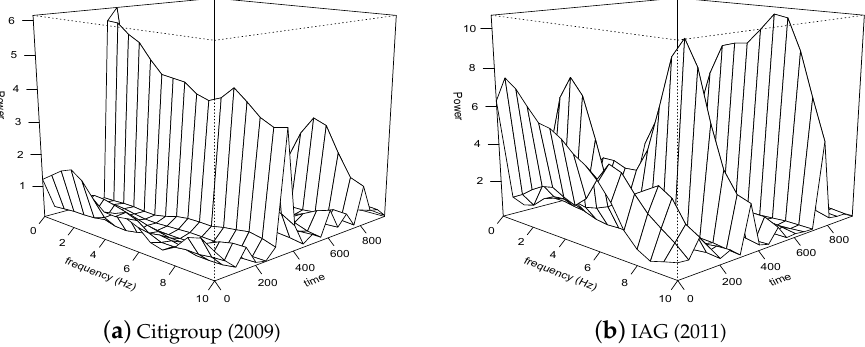
Figure 6. The energy levels of the financial data corresponding to Citigroup and IAG stock